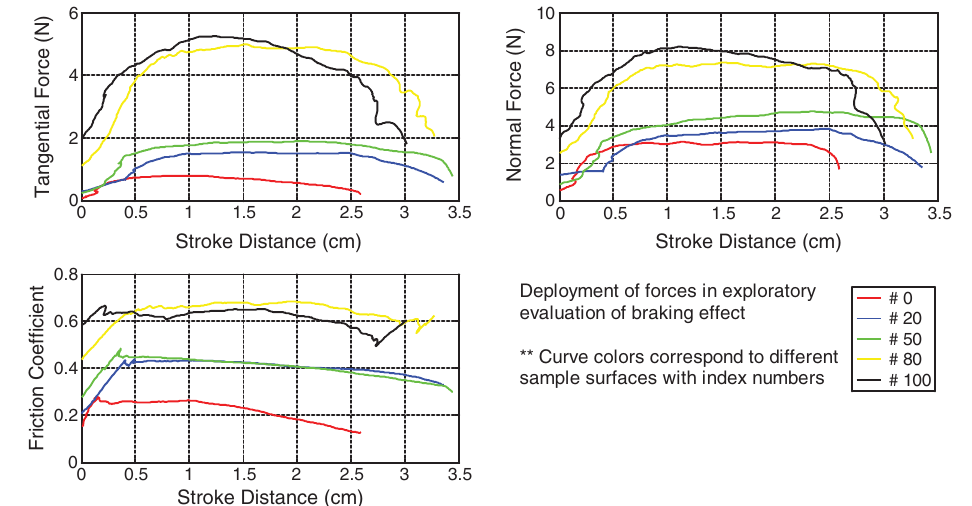
Deployment of forces in exploratory evaluation of braking effect ** Curve colors correspond to different sample surfaces with index numbers